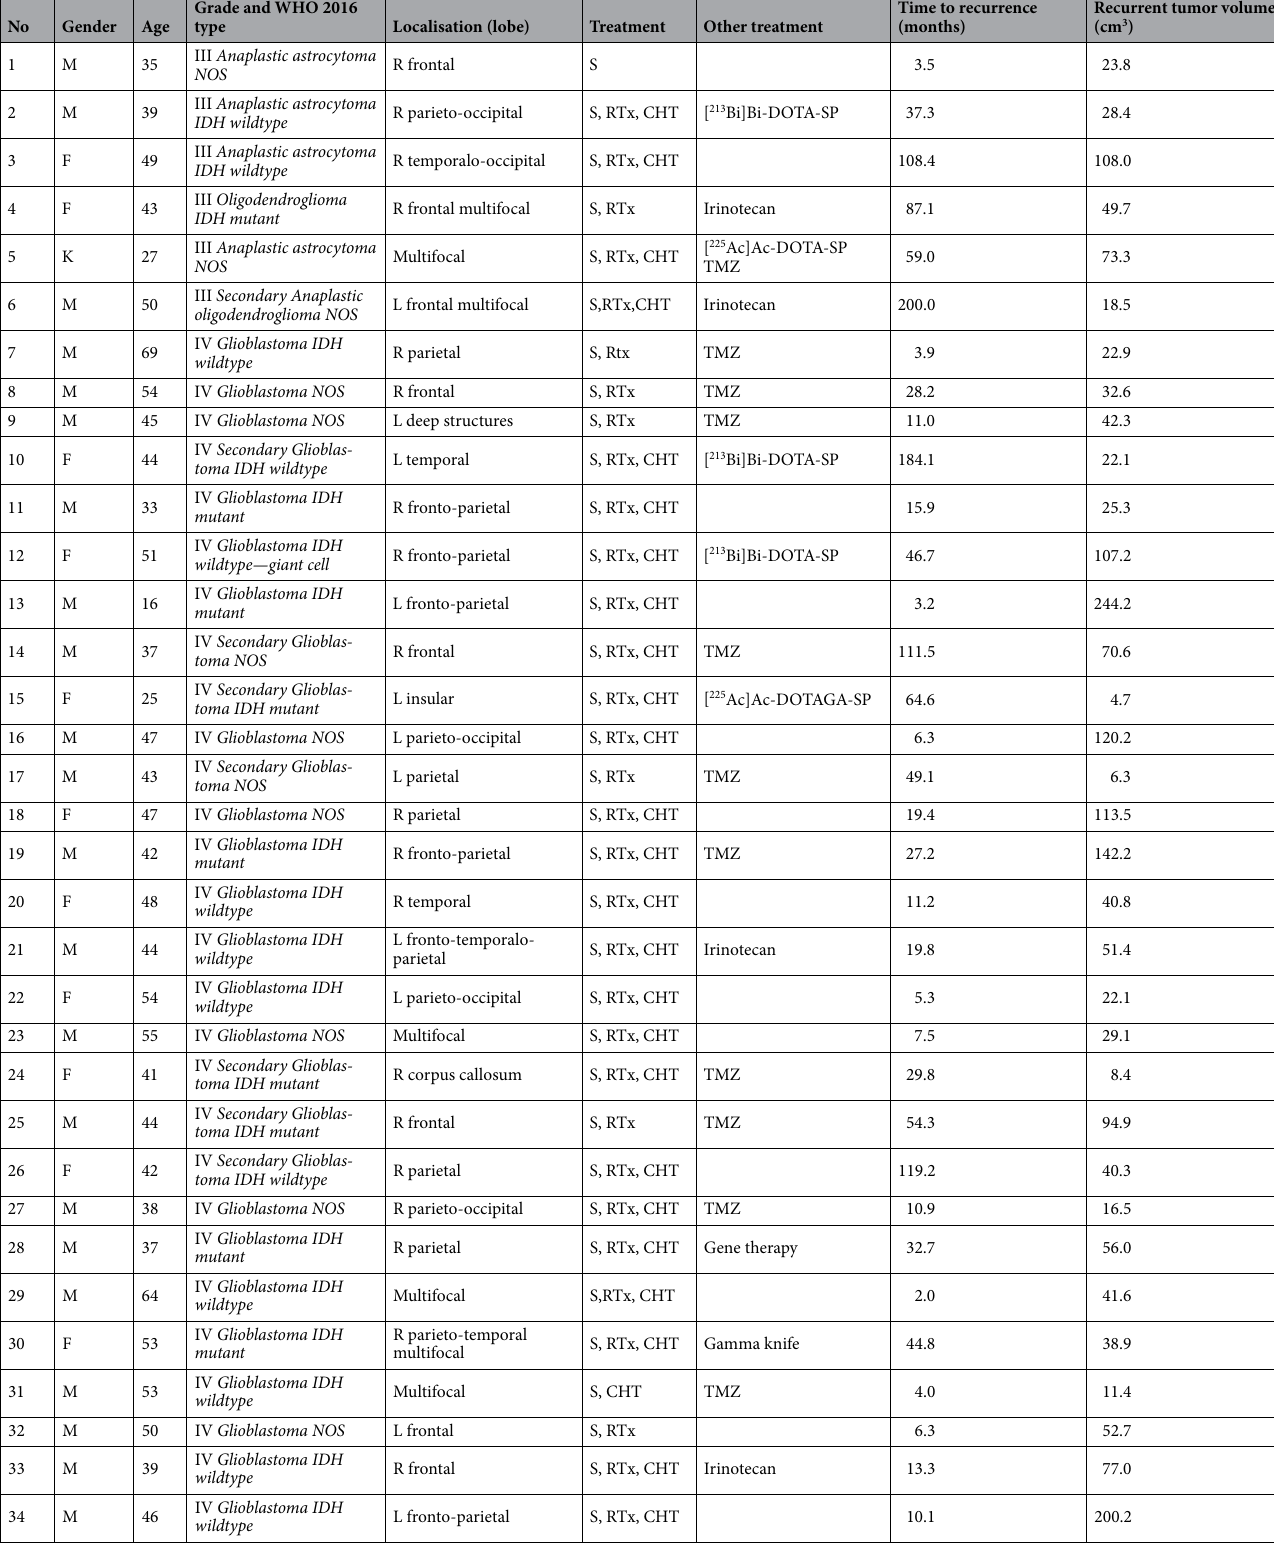
Table 1. Detailed patients’ data. R right, L left, S surgery, RTx radiotherapy, CHT chemotherapy, TMZ